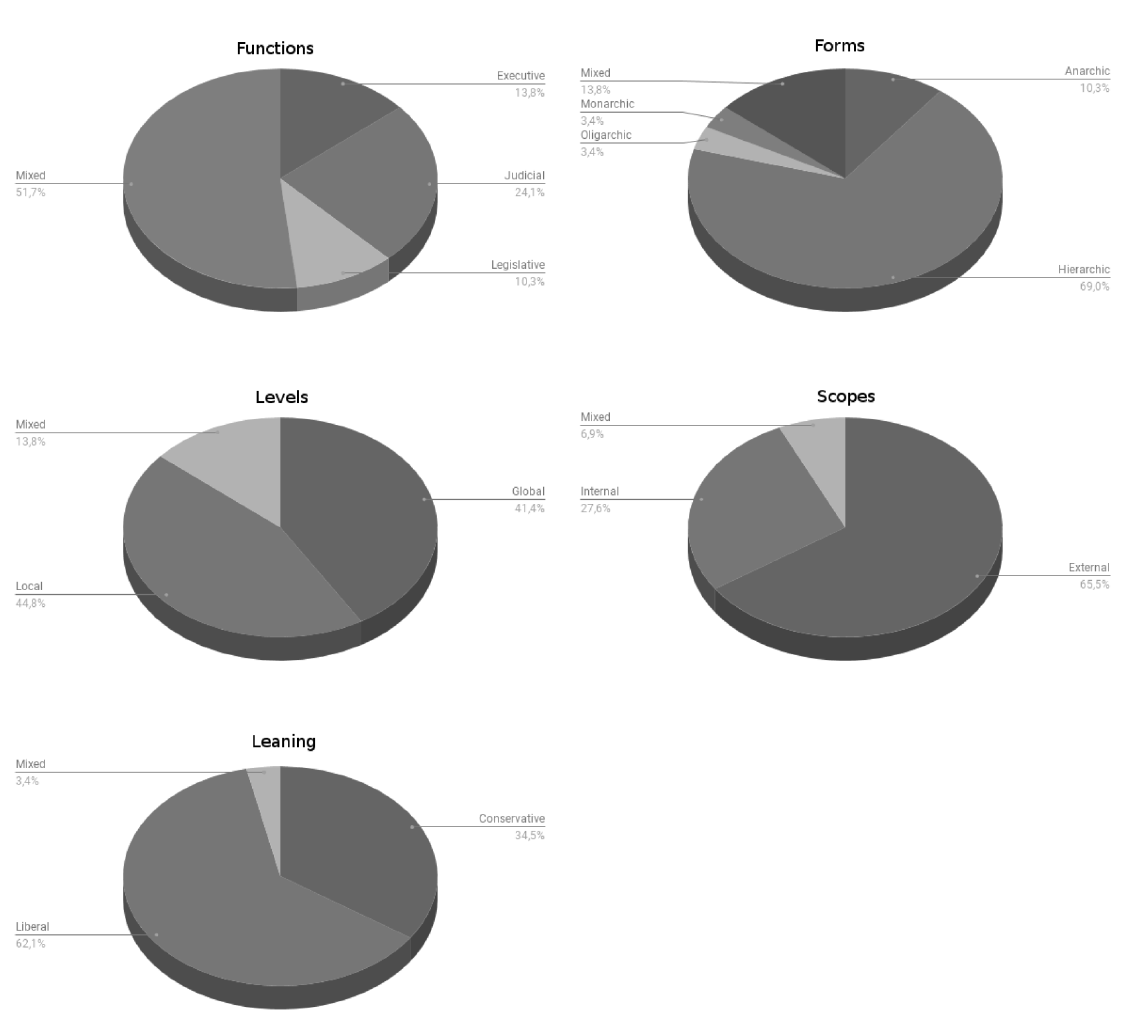
Figure 1. Class thinking styles, global